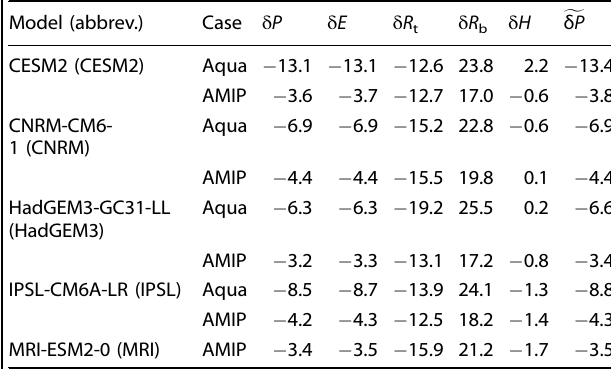
Table 1. Global mean precipitation change and energy budget